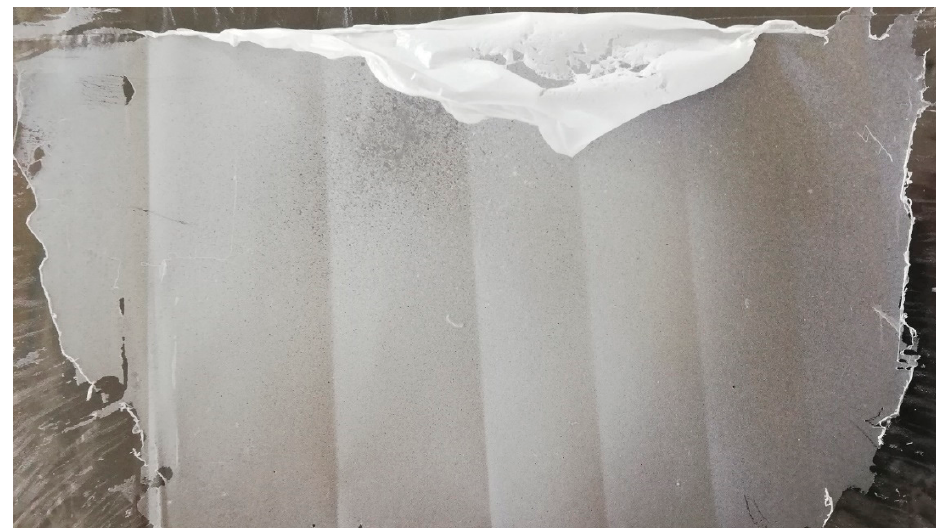
Figure 8. Polypropylene film with a partially displaced PEO (polyethylene oxide) and aqueous G. gracilis extract coating, for the purpose of re-evaluation of antioxidant activities.